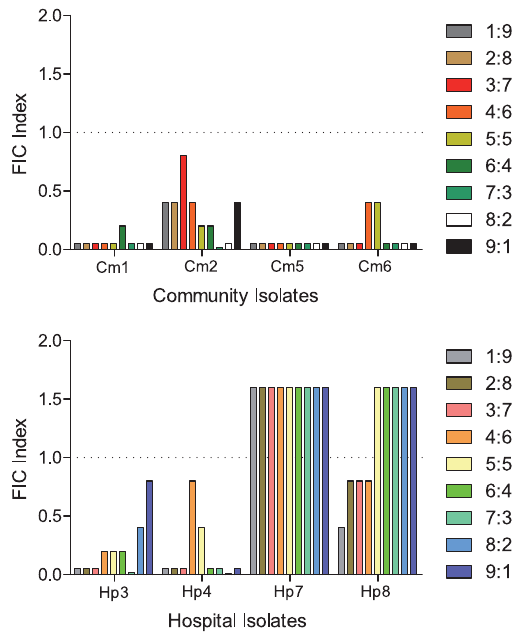
FIGURE 5. Susceptibility of ESBL Isolates to Gentamicin- Cipro fl oxacin antibiotics